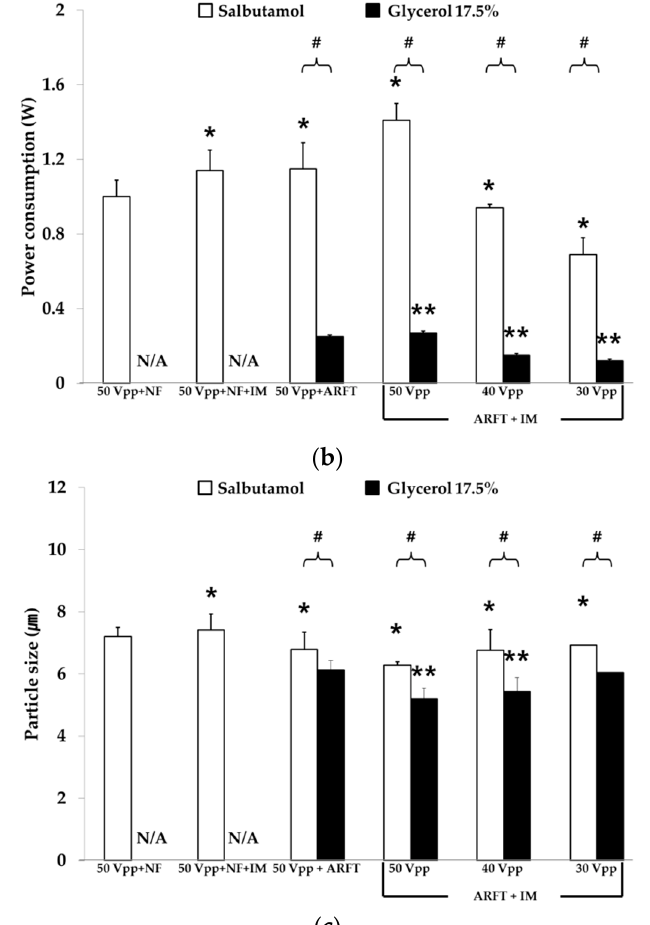
Figure 6. Nebulization characteristics of salbutamol and glycerol solutions after automatic resonance frequency tuning (ARFT) and impedance matching (IM): ( a ) Output rates; ( b ) Power consumptions; ( c ) Particle sizes. Results are presented as means ± SDs. * p < 0.05 versus ‘50 V pp + NF’ for salbutamol, ** p < 0.05 versus ‘50 V pp + ARFT’ for glycerol, # p < 0.05 versus